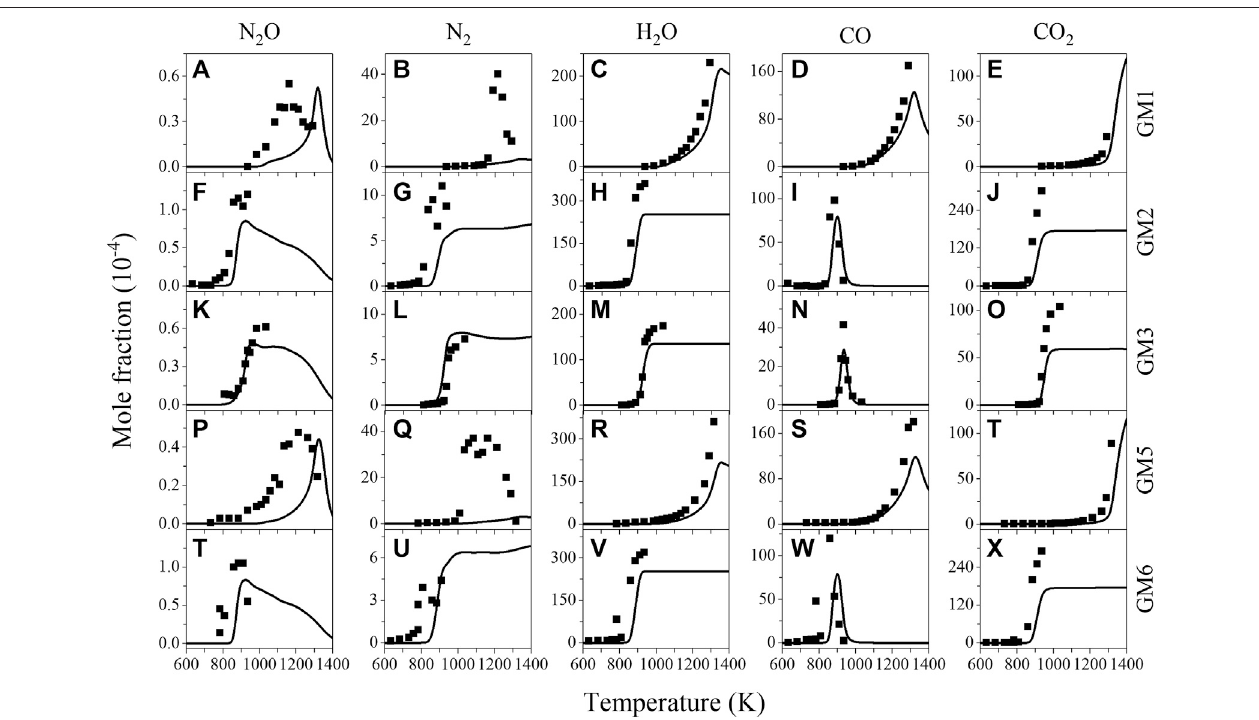
FIGURE2| Experimental(symbols)andsimulated(lines)molefractionpro fi lesofnitrousoxide(N 2 O),nitrogen(N 2 ),water(H 2 O),carbonmonoxide(CO)andcarbon dioxide (CO 2 ) from the oxidation of GM1-3, GM5 and GM6. Experimental data of GM3 are taken from the work of Sun et al. (Sun et al.,